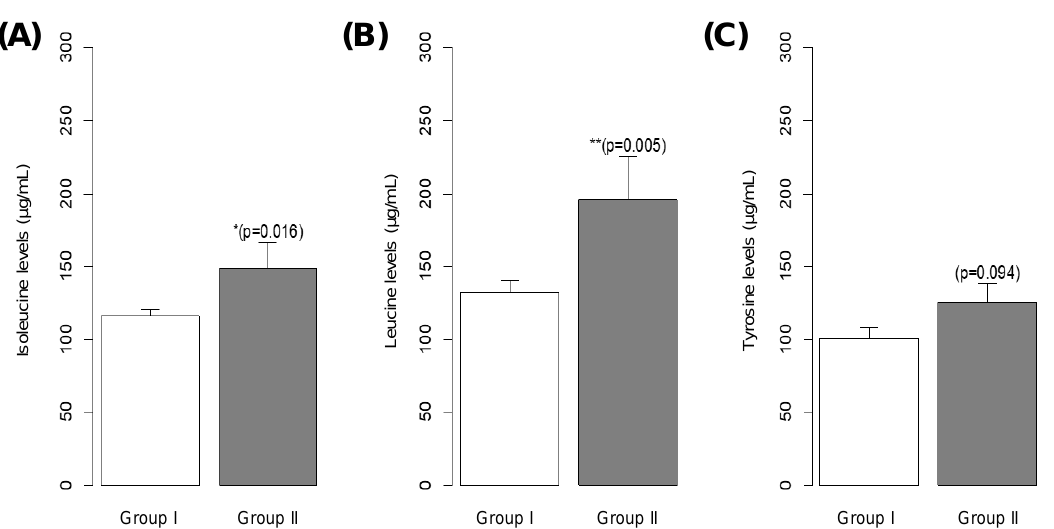
Figure 2. Bar plots for ( A ) Leu, ( B ) Ile and ( C ) Tyr concentration content values (mean ± standard error) and ANOVA/Tukey HSD analyses comparing the two groups.